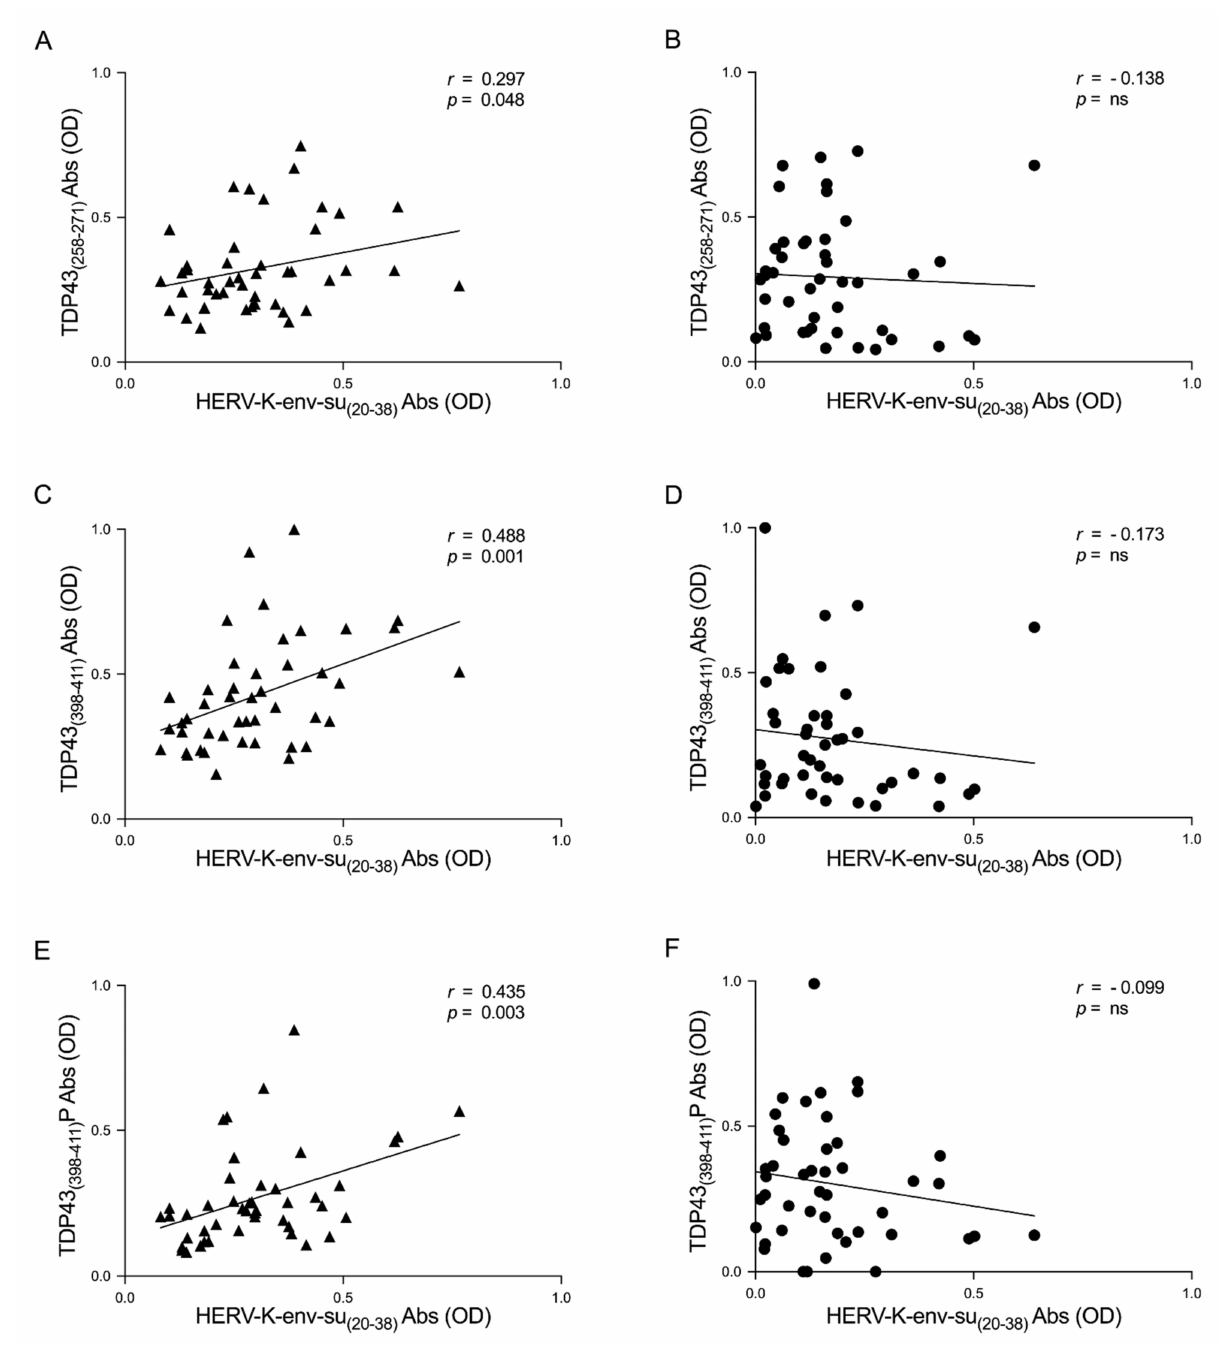
Figure 3. Scatter plots of antibodies to TDP-43, derived peptides, and HERV-K env epitope in ALS populations. The graphs show the correlation between HERV-K-env-su (20–38) and TDP-43 (258–271) , TDP-43 (398–411) , and TDP-43 (398–411) P in ALS patients ( A , C , E ) and in HCs ( B , D , F